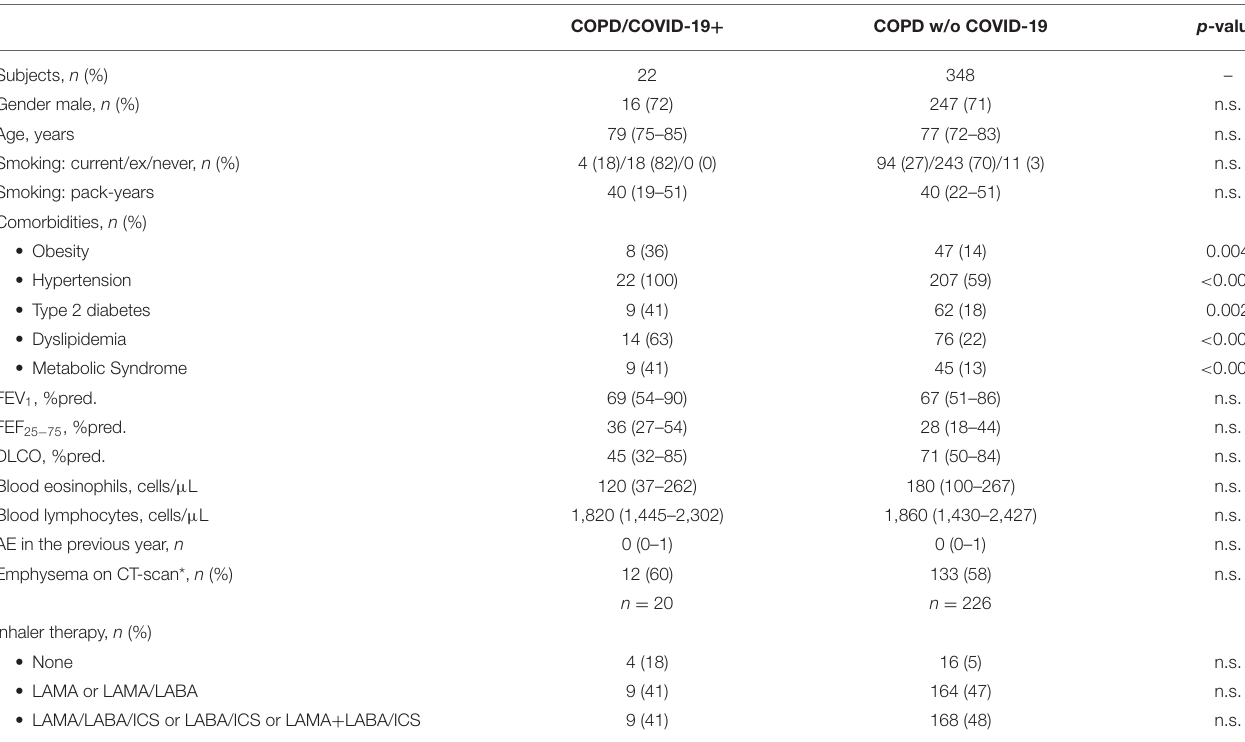
TABLE 1 | Demographic, functional and clinical characteristics of COPD subjects who developed COVID-19 (COPD/COVID-19 + ) and COPD subjects who did not (COPD w/o